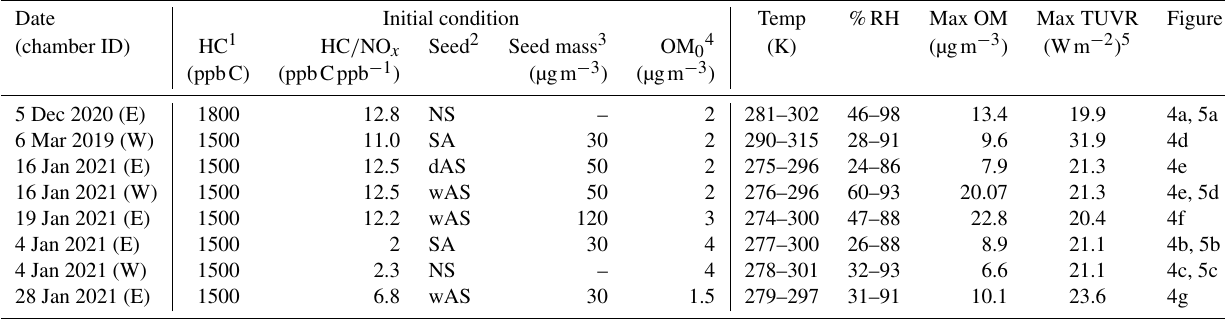
Table 1. Experimental conditions for the photooxidation of the gasoline in the UF-APHOR chamber. Date Initial condition Temp (chamber